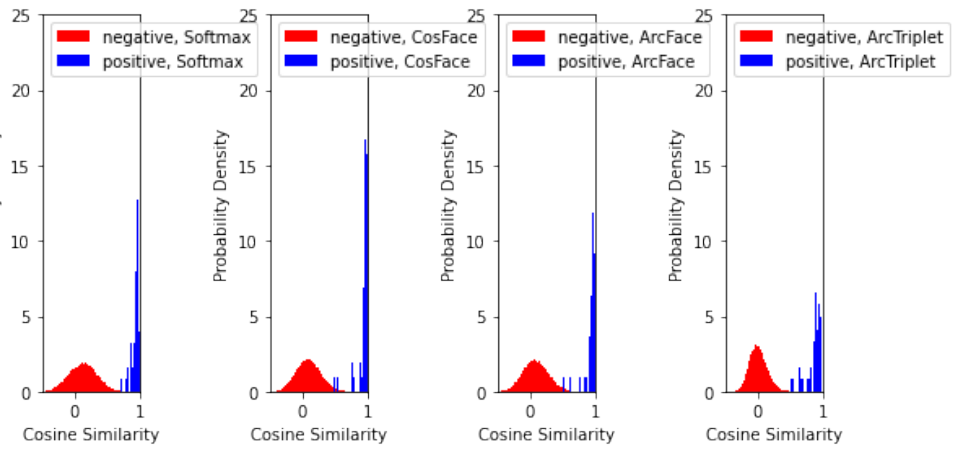
Figure 8. Histograms of positive and negative similarity distribution on the evaluating result for CASIA-Iris-Thousand.